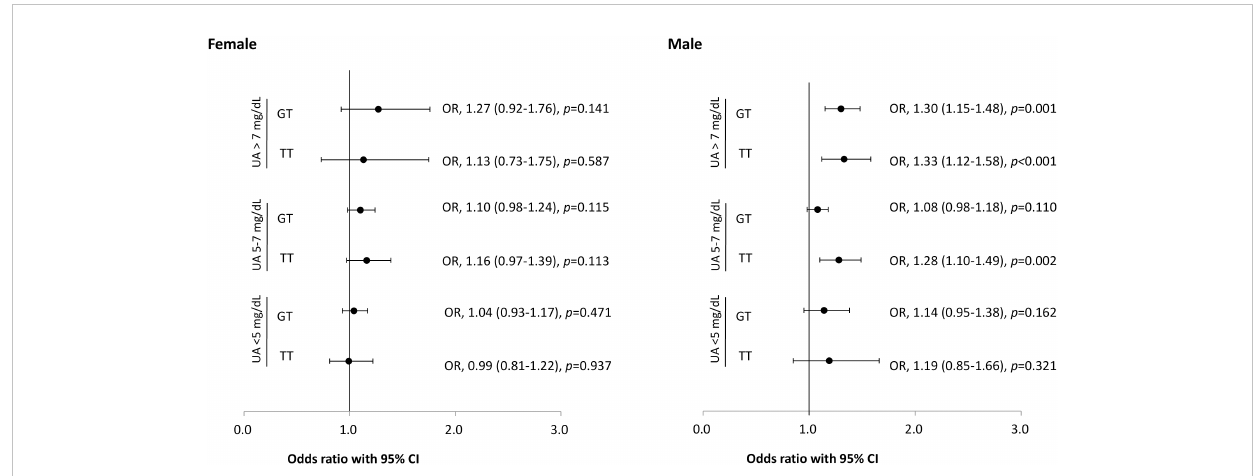
FIGURE 1 Risk of nephrolithiasis and ABCG2 rs2231142 genotypes strati fi ed by sex and serum uric acid levels. Error bars represent the 95% con fi dence intervals (CI) of the odds ratios (OR). UA: uric